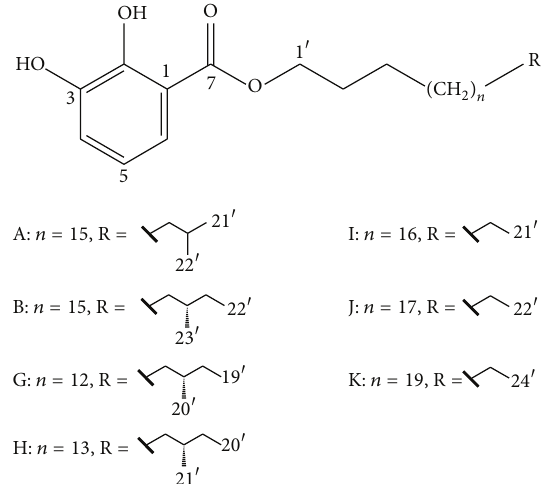
Figure 1: Chemical constitution of seven kinds of gentisides (gentisides A, B, G, H, I, J, and